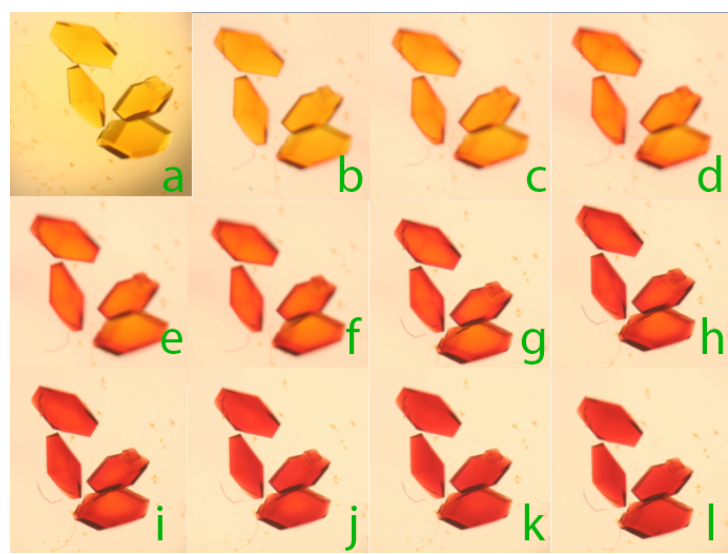
Figure 4. Tetragonal lysozyme crystals were saturated with the dye m-cresol purple at pH 5, which gave the crystals a yellow/orange color. The pH of the mother liquor was changed to pH 7.5 and the conversion of the crystal color to red provided a measure of the diffusion of H 3 O + ions out of the crystal into the mother liquor. The total time required for the transition was about 30 min. The series of images ( a – l ), taken at appropriate time intervals, shows the progress of the dye.